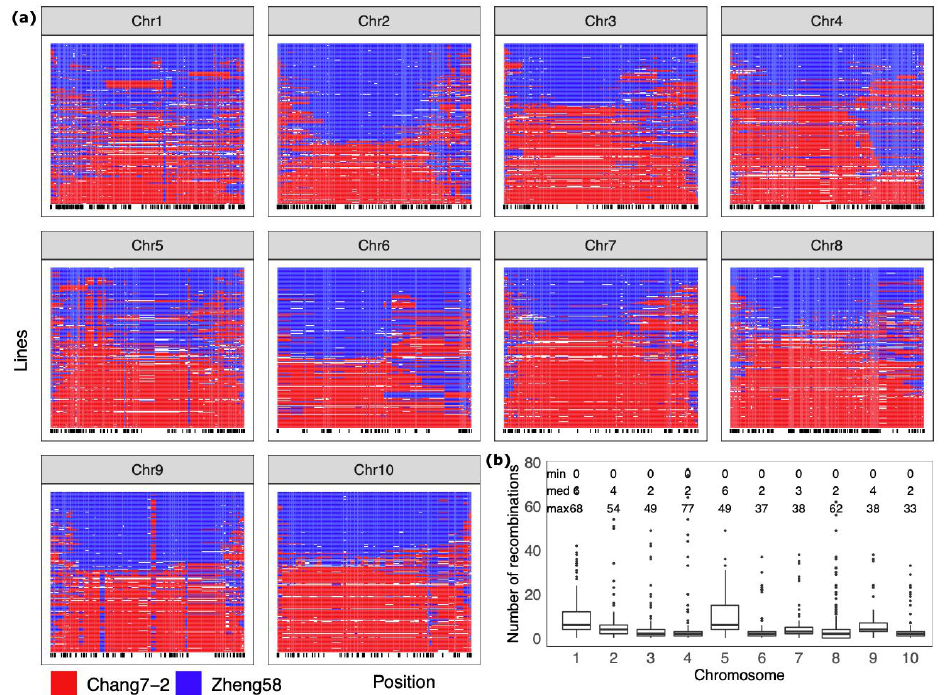
Figure 2. Characterization of genomic segment composition of DH lines: ( a ) reconstructed recombi- nation events in DH lines on each chromosome. The red color marks genotypes of DH lines identical to the parental line Chang7-2, whereas the blue color marks genotypes identical to the other parent, Zheng58. Black bars at the bottom of each chromosome plot indicate the physical positions of SNP markers. ( b ) Number of inferred recombination per chromosome events across all DH